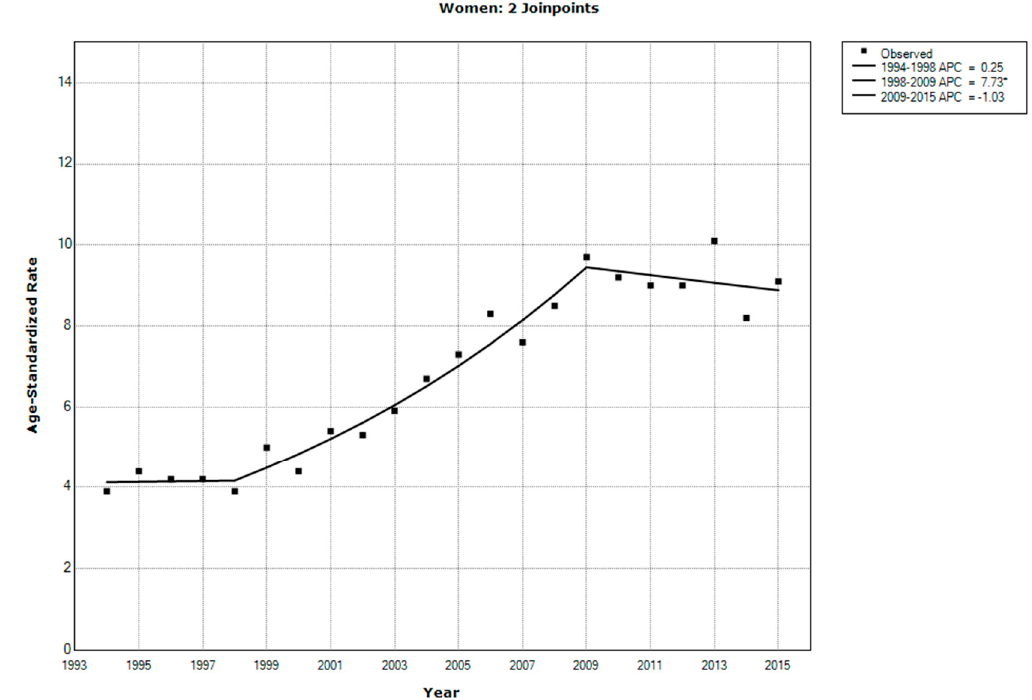
Figure 2. Trends in the age-standardized incidence rates for colorectal cancer among women in Saudi Arabia, 1994–2015. * indicates that the annual percent change is significantly different from zero at the alpha = 0.05 level. Final selected model: 2 Joinpoints.